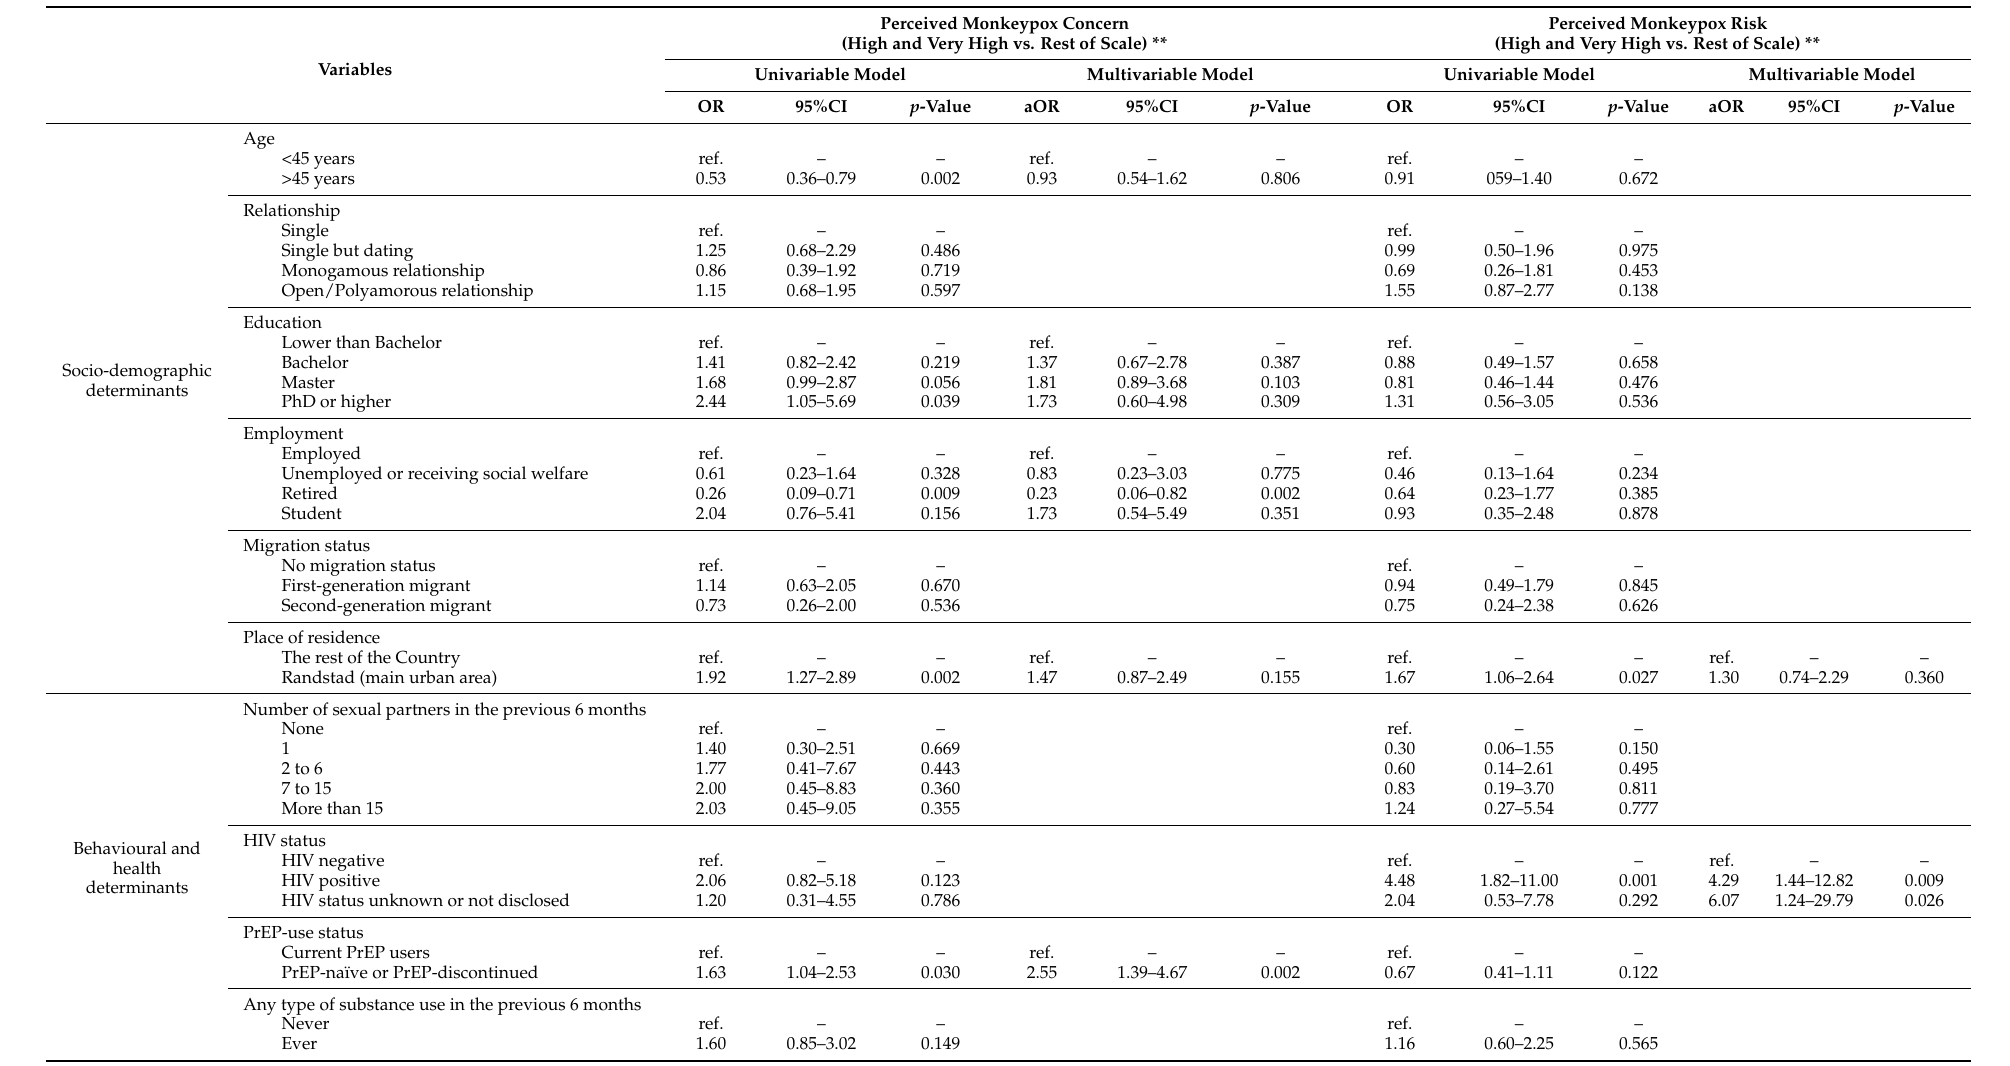
Table 3. Determinants of perceived concern about and perceived risk of getting monkeypox among MSM in The Netherlands, July 2022.